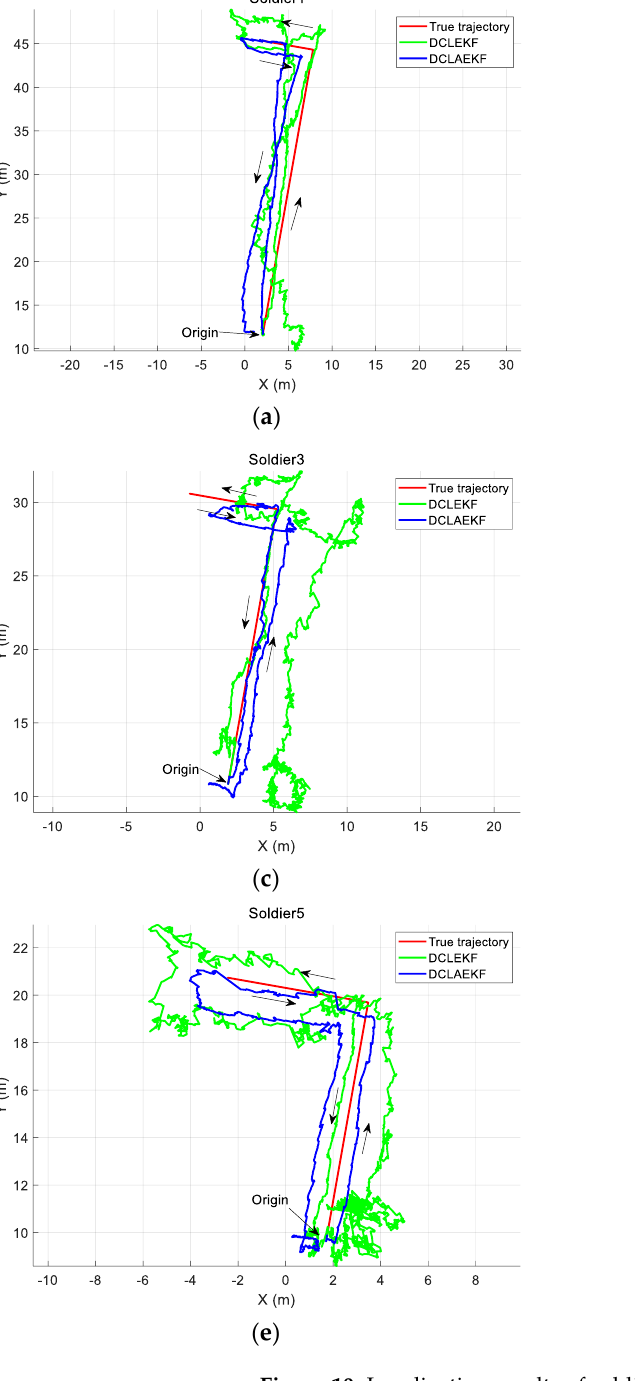
Figure 10. Localization results of soldiers using different algorithms in a forest environment exper- iment. ( a ) Localization results of soldier 1; ( b ) Localization results of soldier 2; ( c ) Localization results of soldier 3; ( d ) Localization results of soldier 4; ( e ) Localization results of soldier 5; ( f ) Localization results of soldier